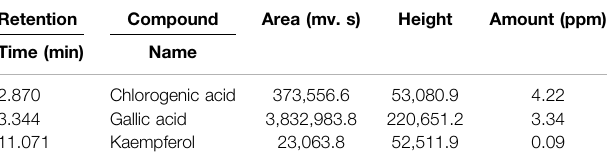
TABLE 5 | Quanti fi cation of different bioactive